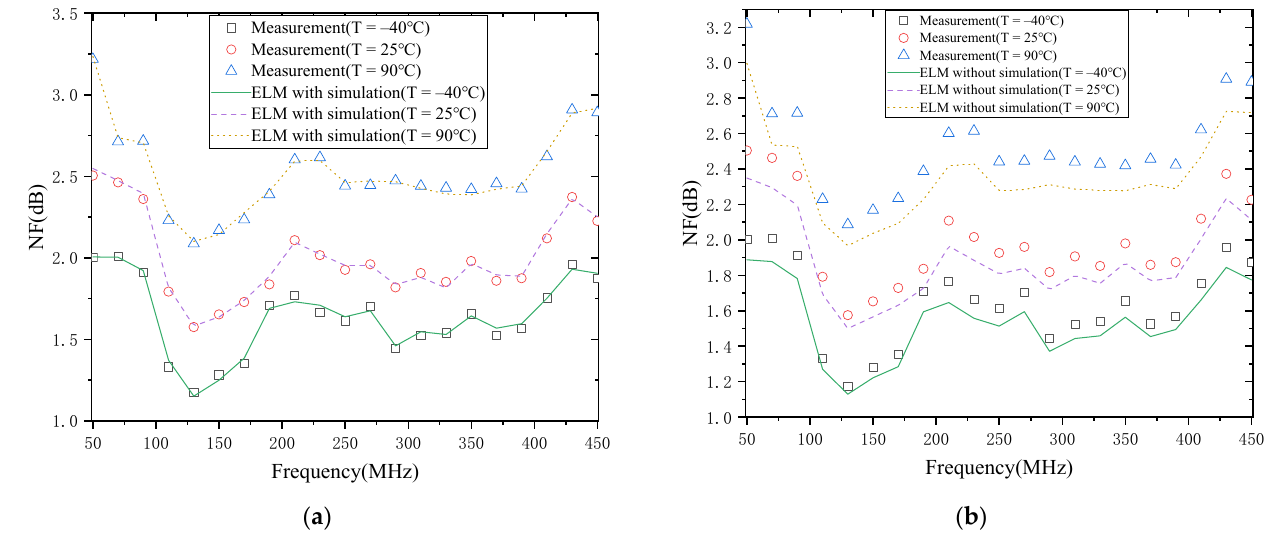
Figure 8. NF of the LNA: ( a ) with simulation; ( b ) without simulation. In addition, it can be found that the change in NF is different at different frequencies when the magnitude of temperature change is the same. For example, when the temperature increases from − 40 °C to 90 °C, the NF increases by 1.22 dB and 0.74 dB at 50 MHz and 270 MHz, respectively, which shows that the carrier mobility increases are not only temperature-dependent but also frequency-dependent. Then, from the results in Figure